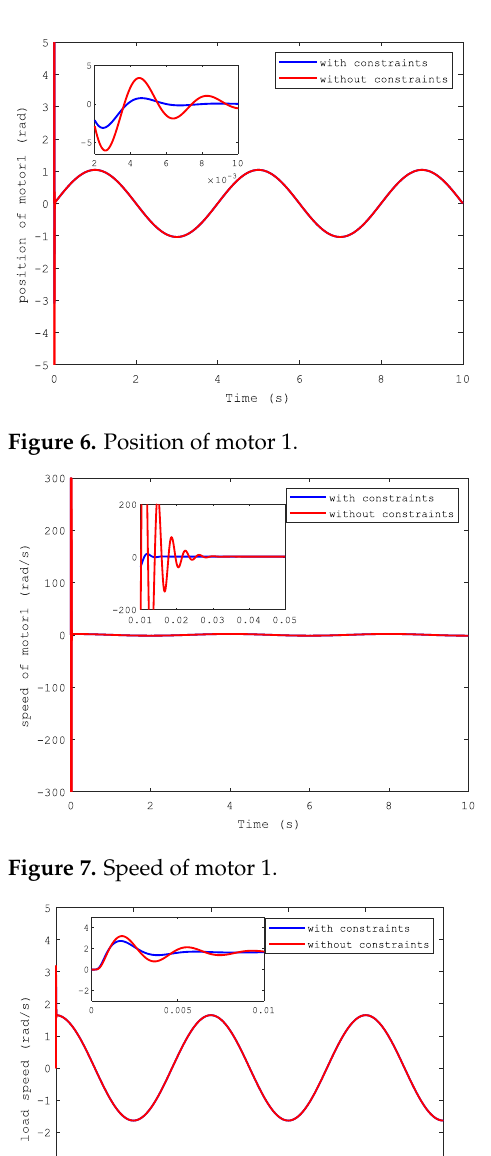
Figure 8. Load speed.